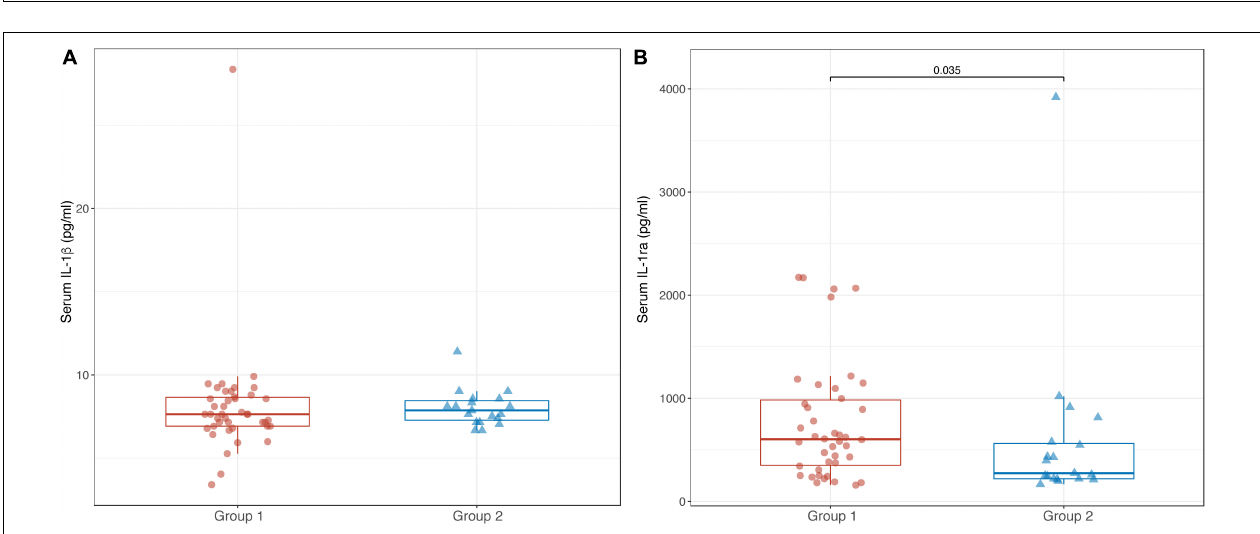
FIGURE 2 | Box-plots showing serum levels of IL-1 β (A) and IL-1ra (B) in control subjects and in the overall CAD population. Boxes are defined by Q1, median (bold line) and Q3. Whiskers reach the minimum and the maximum of the distribution except for the presence of outliers, defined as data points below Q1 – 1.5 × IQR or above Q3 + 1.5 × IQR. To avoid overlapping a small amount of horizontal jitter was added. Q1, first quartile; Q3, third quartile; IQR = Q3 – Q1.